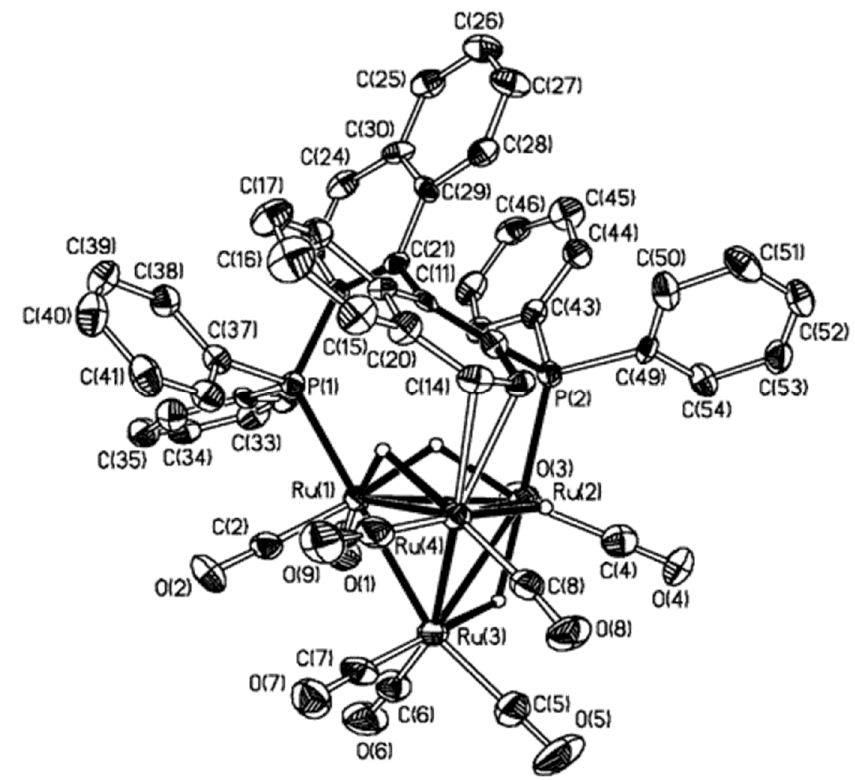
Figure 4. Η 4 Ru 4 (CO) 9 [ μ 3 ‐ ( S ) ‐ BINAP] catalyst. Adapted with permission from reference [139].